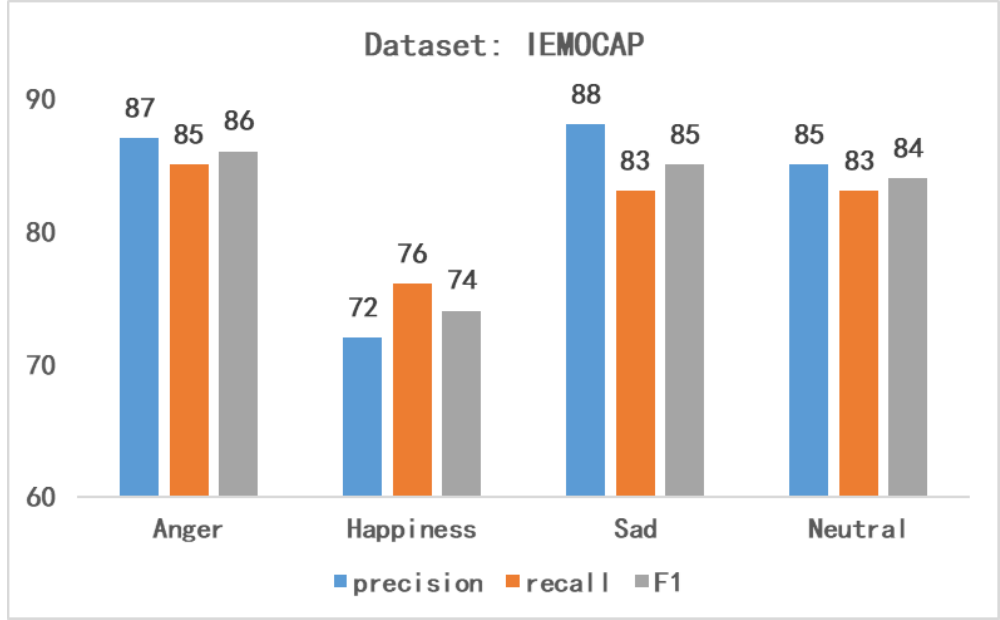
Figure 7. Recognition of different emotions by the proposed method.